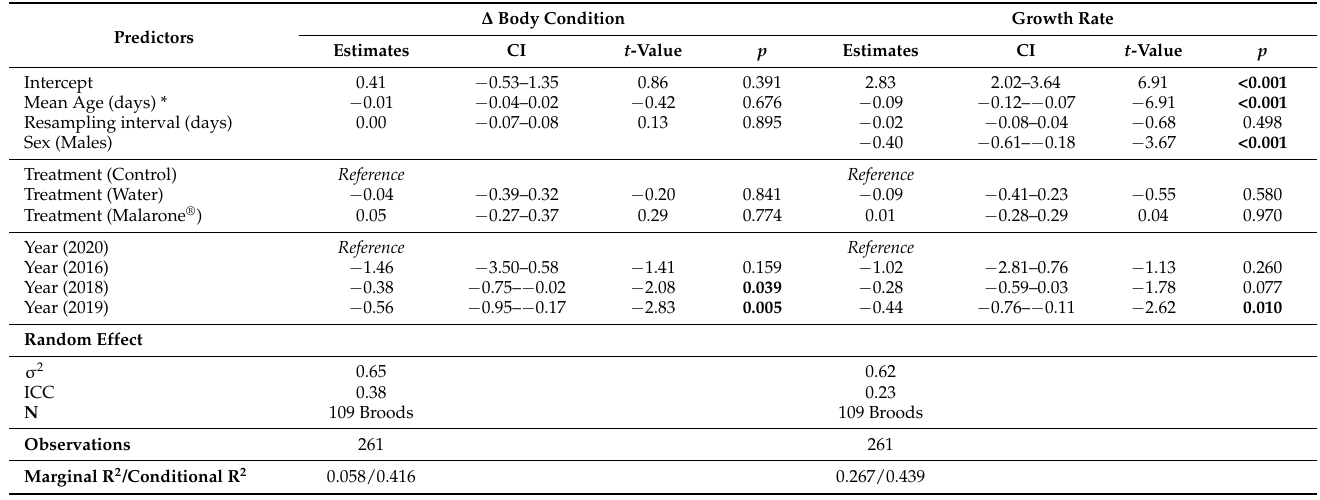
Table 1. Treatment effects on body condition and growth rate of common buzzards.